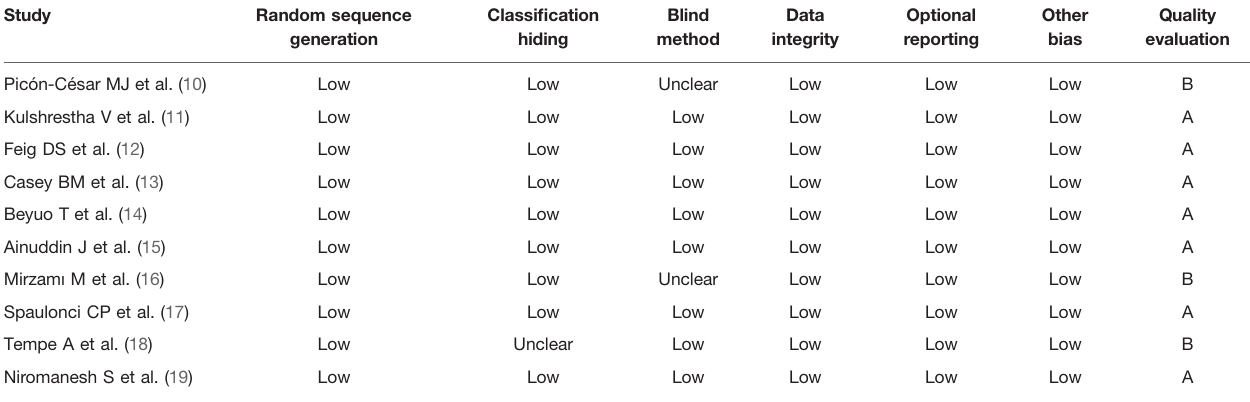
TABLE 2 | Risk of bias assessment and quality evaluation based on Cochrane